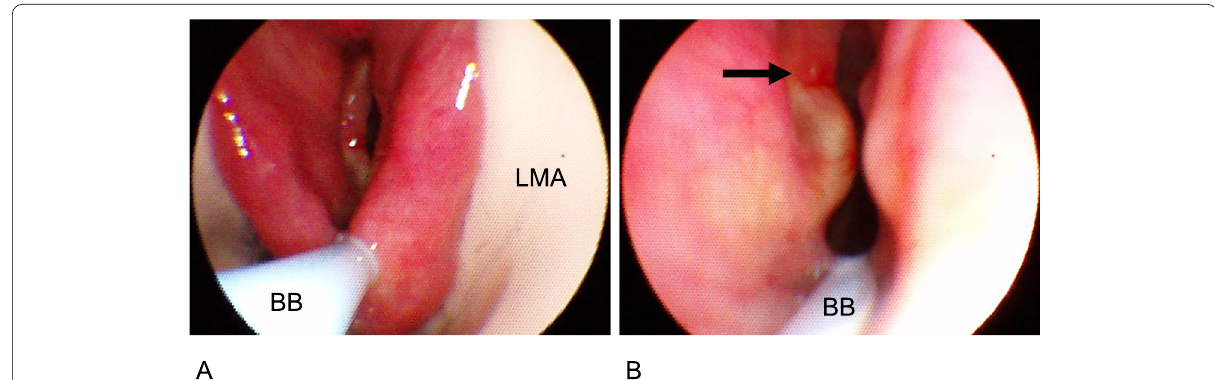
Fig. 1 A General view of laryngoscopy. BB, bronchial blocker; LMA, laryngeal mask airway. B Laryngoscopy of vocal cord lesion. Black arrow, an elevated lesion on the vocal cord. The bronchial blocker passes through a position far enough from the vocal cord